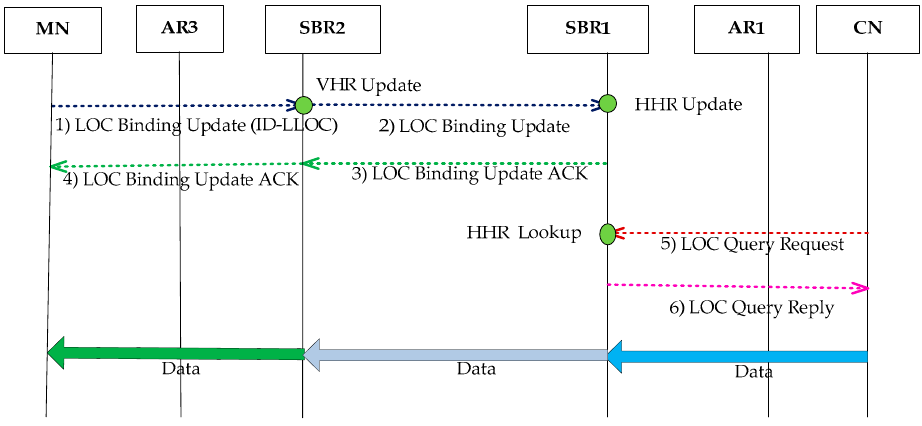
Figure 7. Binding and query operations for roaming.